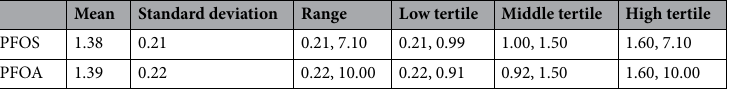
Table 2. Measured concentrations of cord serum PFOS and PFOA (ng/mL). NB: PFOS denotes perfluorooctane sulfonate; PFOA denotes perfluorooctanoic acid.